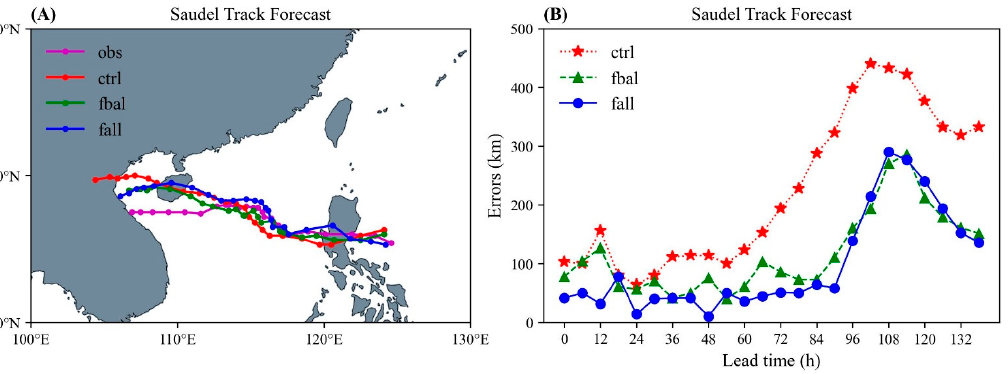
Figure 6. Tracks of Saudel ( A ) and corresponding track errors ( B ) compared with the IBTrACS best track data. Three forecasts from the “ctrl”, “fbal”, and “fall” runs with the initial time at 0000 UTC on